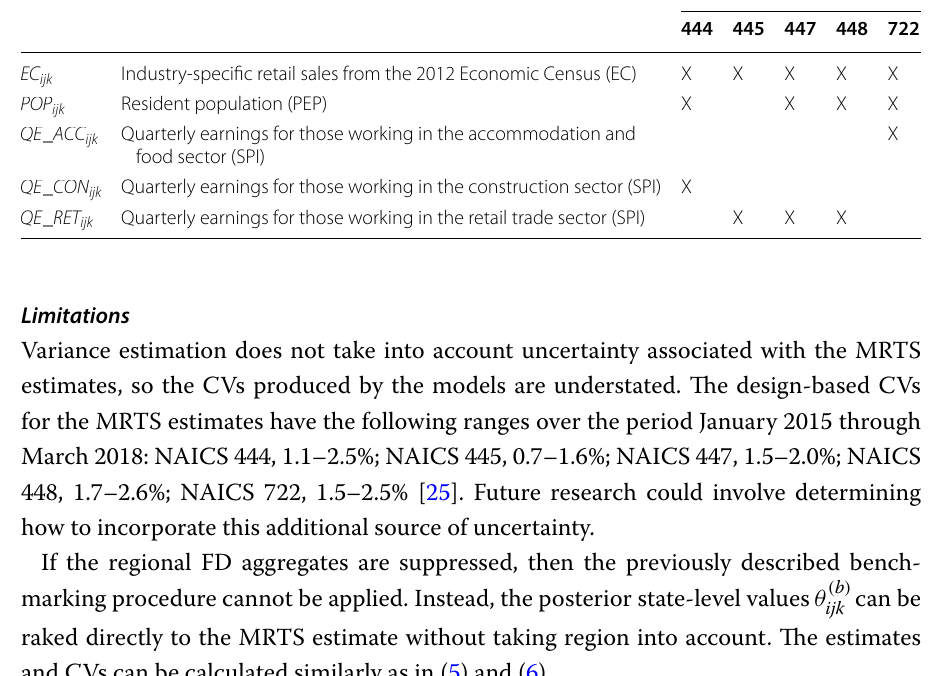
Table 8 Summary of model covariates Model